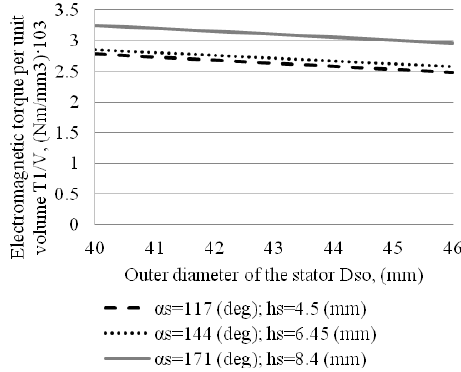
Fig. 7. Maximum value of electromagnetic torque per unit volume according to outer diameter of the